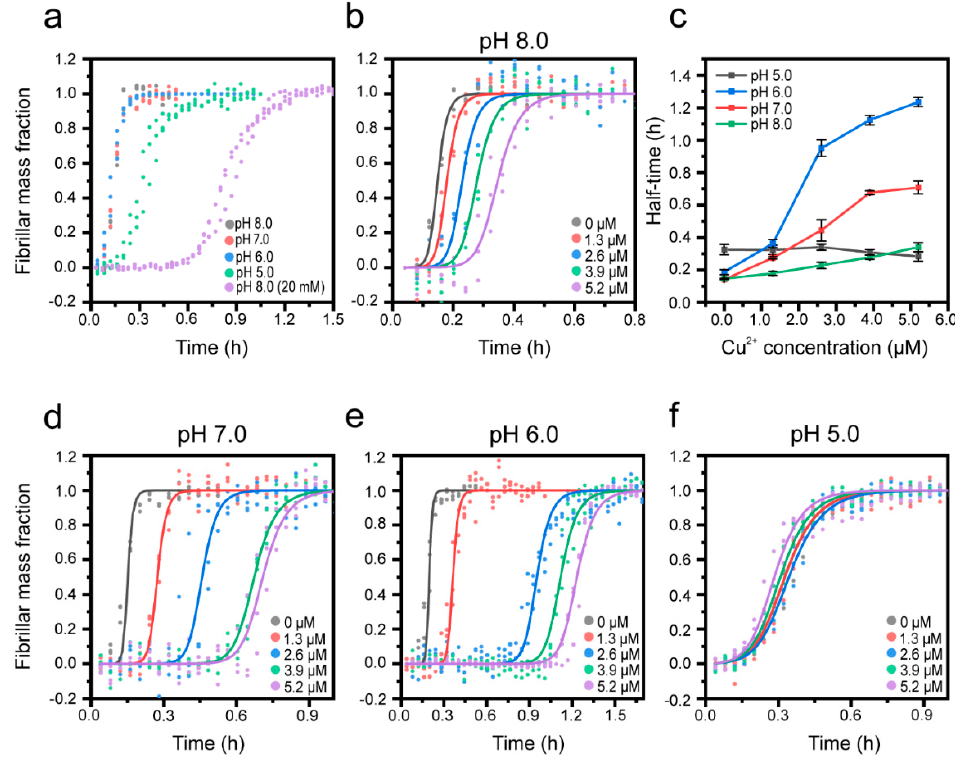
Figure 3. Cu 2+ inhibition of A β (1-42) amyloid formation at different pHs. ( a ) Normalized kinetic profiles of 2.6 μ M A β (1-42) at various pHs. ( b ) Normalized kinetic profiles of 2.6 μ M A β (1-42) in a 200 mM sodium phosphate buffer, pH 8.0, and in the presence of Cu 2+ . ( c ) Half-times of the aggregation of 2.6 μ M A β (1-42) at various pHs in the presence of increasing concentrations of Cu 2+ . ( d – f ) Normalized kinetic profiles of 2.6 μ M A β (1-42) in the presence of increasing concentrations of Cu 2+ , recorded in 200 mM citrate-phosphate buffers adjusted to ( d ) pH 7.0, ( e ) pH 6.0 , and ( f ) pH 5.0. 3.3. Cu 2+ -Mediated Inhibition of A β (1-42) Aggregation Affects the Fibril Elongation Step